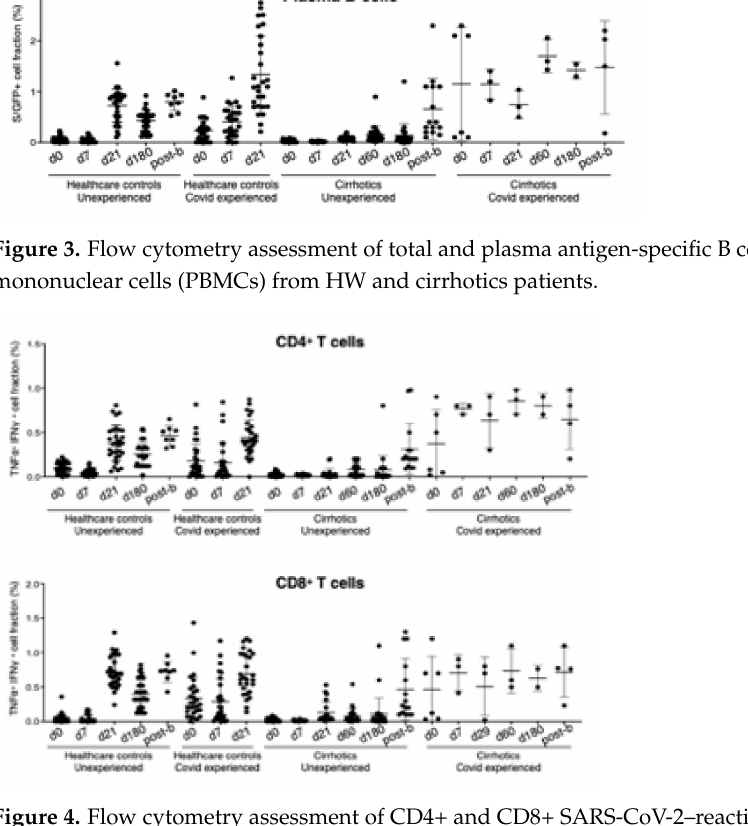
Figure 4. Flow cytometry assessment of CD4+ and CD8+ SARS-CoV-2–reactive T cells in peripheral blood mononuclear cells (PBMCs) from HW and cirrhotics